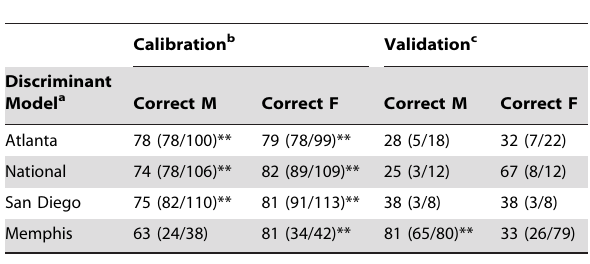
Experiment 4: Male:Female discrimination within ‘‘leaf only’’ calibration set